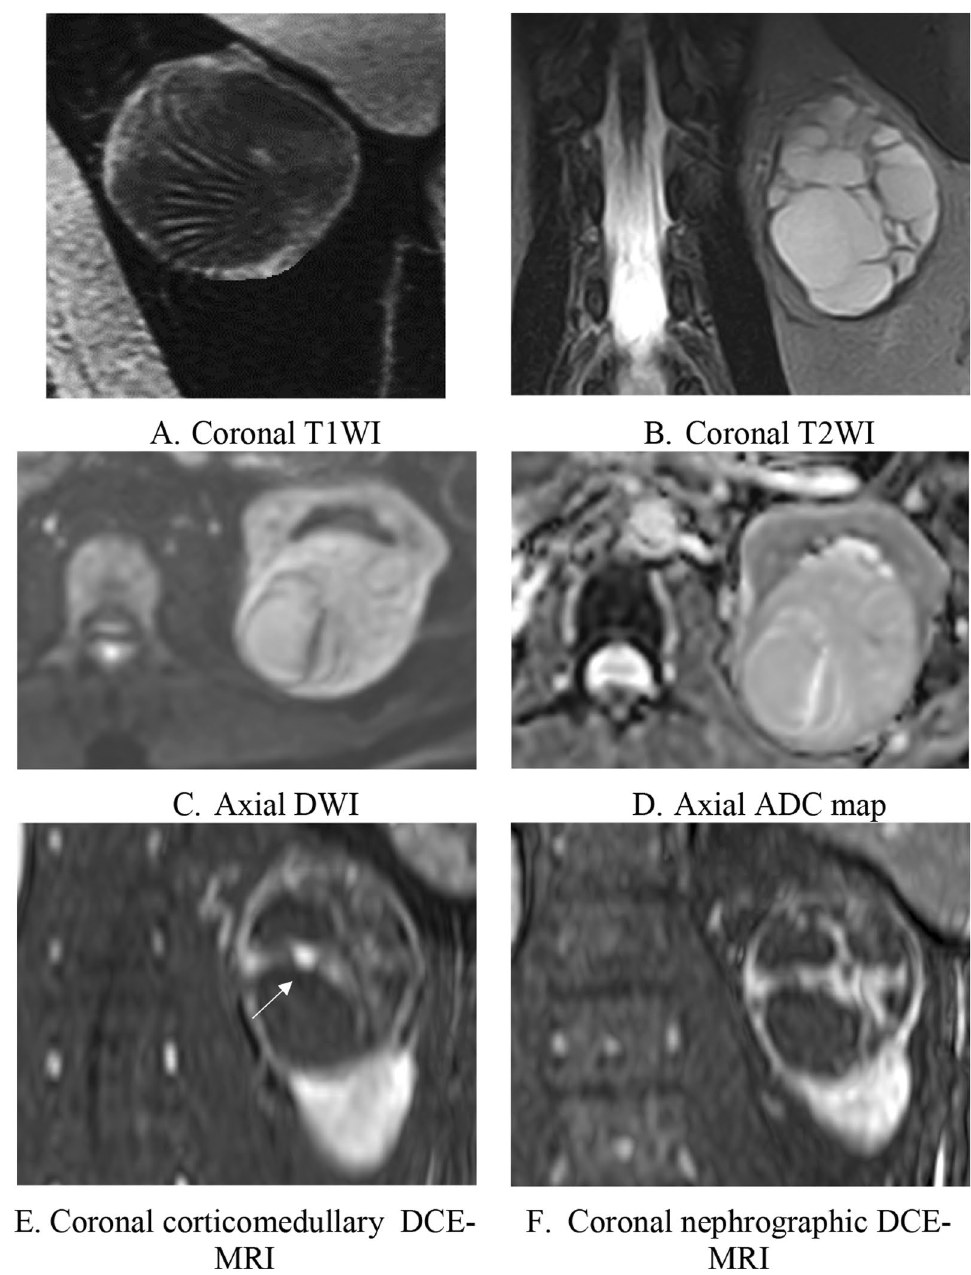
Fig. 7 Left renal cystic mass (Bosniak III). Coronal T1WI ( A ) a well‑defined left upper polar and midzonal exophytic thick‑walled parenchymal multilocular cystic lesion measuring 7.6 cm in its maximum dimension. The lesion is hypointense with thick septae of intermediate signal inside with no suspicious nodules inside. In Coronal T2WI ( B ), the lesion appears hyperintense with intermediate signal of the septae with no suspicious nodules inside. Axial DWI ( C ) b 800 mm 2 /s & axial ADC map ( D ) Showed no restricted signals. Coronal corticomedullary ( E ) and = nephrographic ( F ) DCE‑MRI subtracted images: showed multiple enhancing septae with enhancing septal mural nodule (Enhancing obtuse convex protrusion < 3 mm) (arrow). The pathology was papillary renal cell